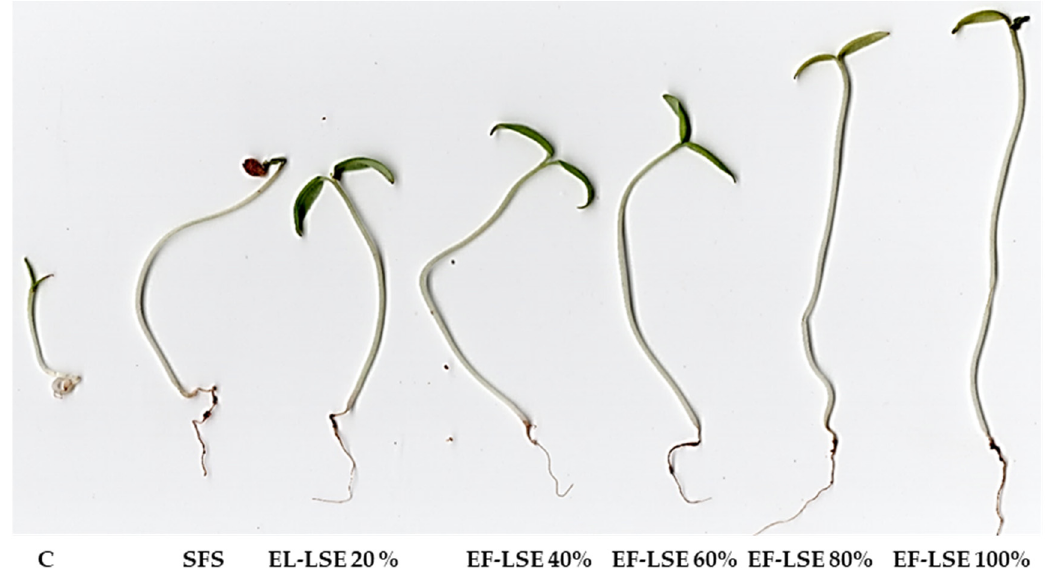
ff ect of LSEs on growth of tomato Figure 5. Effect of LSEs on growth of tomato seedlings. Figure 5. E Figure 5. Effect of LSEs on growth of tomato seedlings.